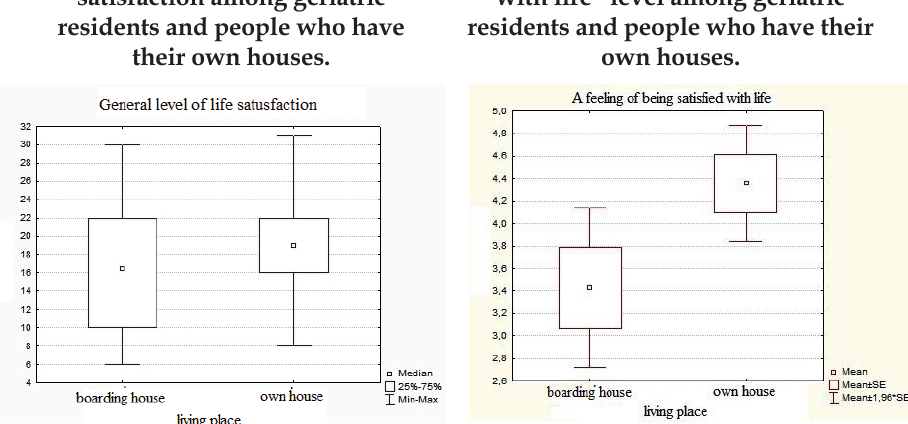
discomfort, low subjective assessment of life. Social support for families increases life satisfaction of people who live in their own houses. Fig. 2a: General level of life satisfaction among Fig. 2b: “Feeling of being satisfied with life” level Fig. 2a: General level of life Fig. 2b: “Feeling of being satisfied geriatric residents and people who have their own among geriatric residents and people who have satisfaction among geriatric with life” level among geriatric houses. their own residents and people who have residents and people who have their their own houses. own houses.